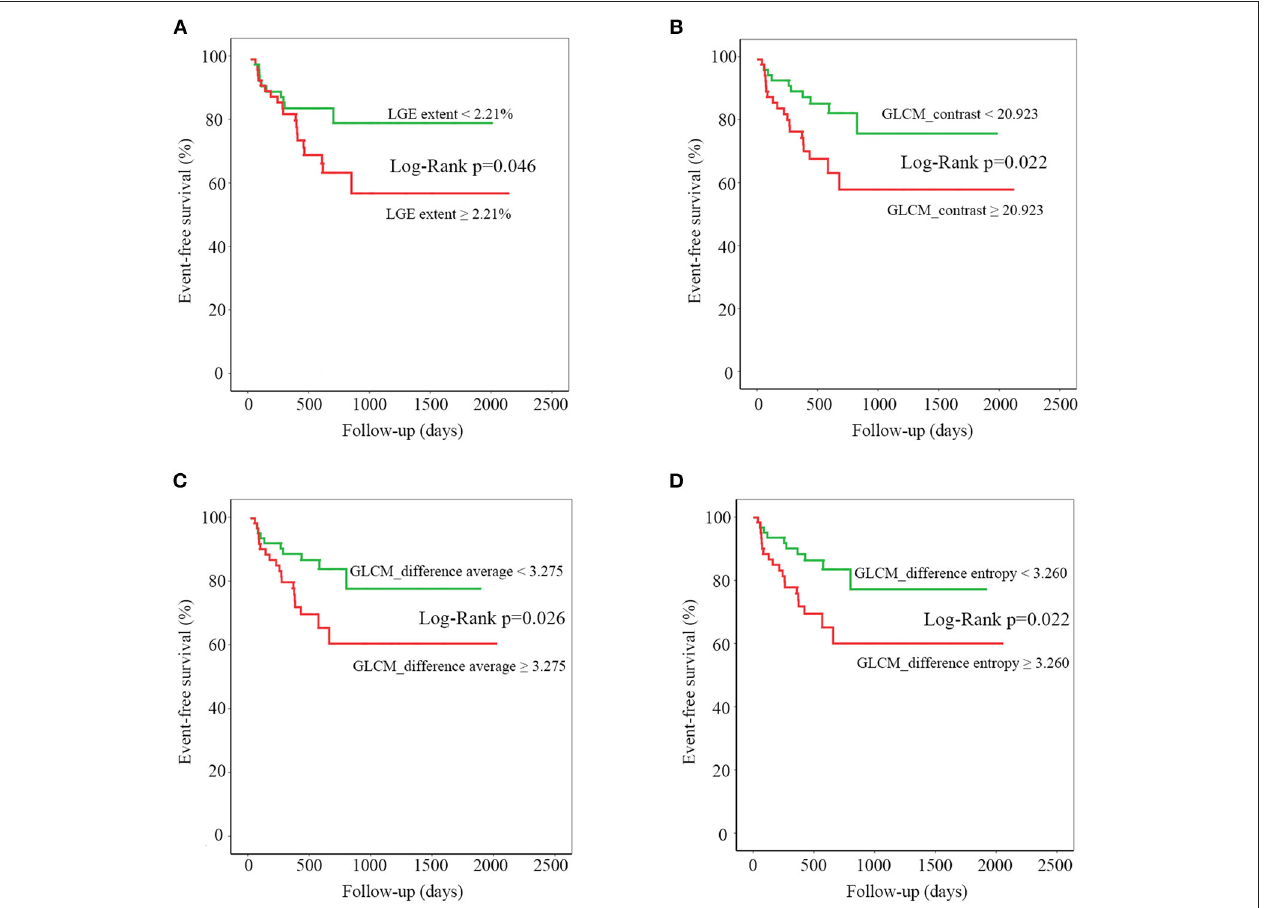
FIGURE 3 | Kaplan-Meier curves for late gadolinium enhancement (LGE) extent (A) , gray-level cooccurrence matrix (GLCM)_contrast (B) , GLCM_difference average (C) , and GLCM_difference entropy (D) . For each texture feature, median value was chosen to divide the entire patient population into two parts. Statistical difference between curves was measured using the log-rank test.